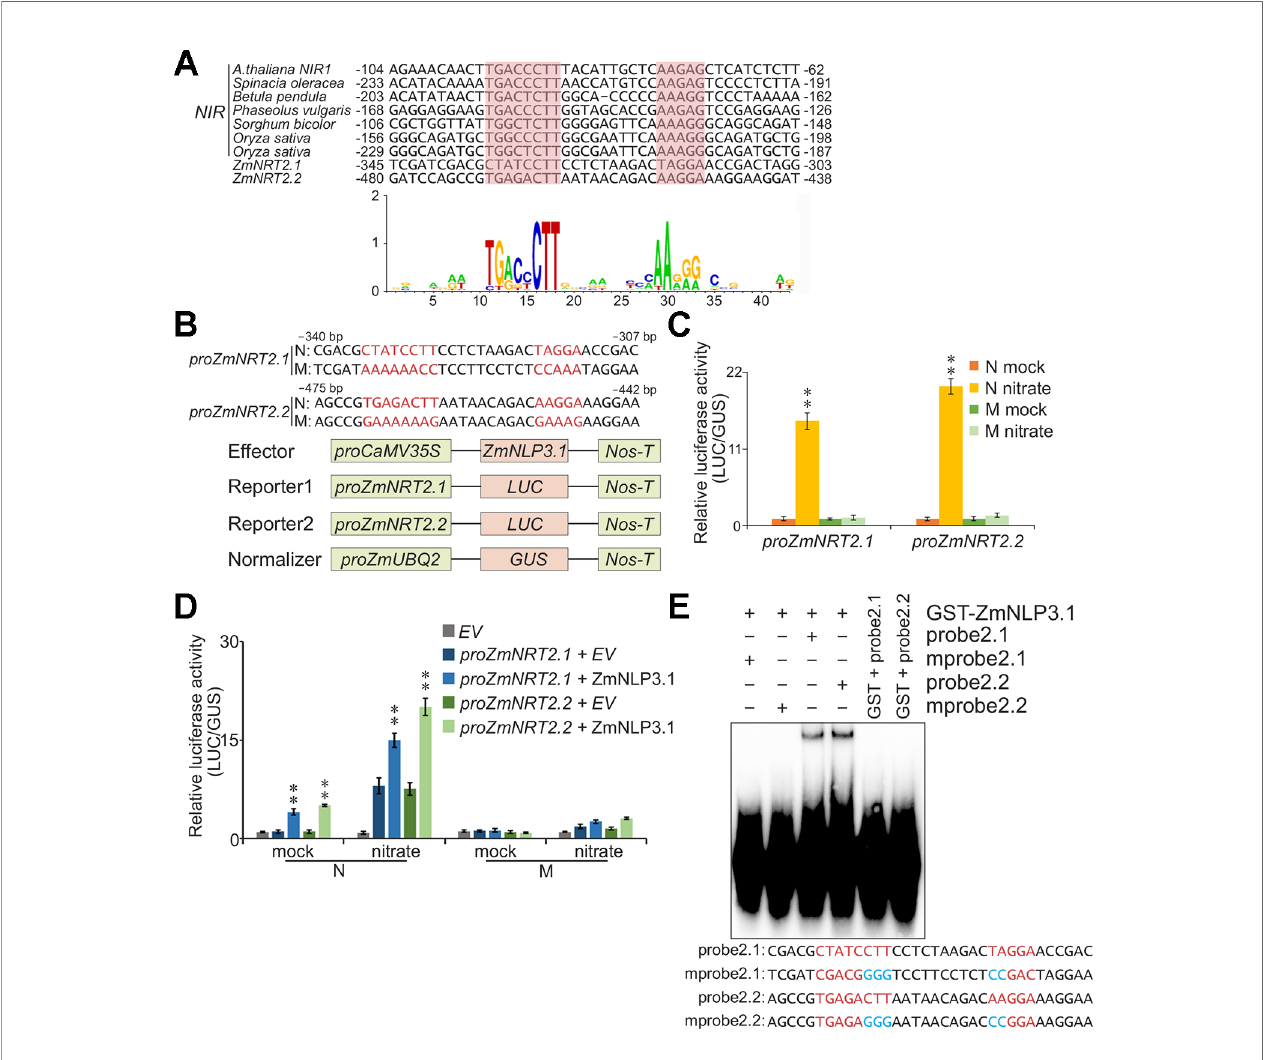
FIGURE 5 | ZmNLP3.1 binds to the promoter regions of ZmNRT2.1 and ZmNRT2.2 via the recognition of NREs and activates gene transcription. (A) Nucleotides sequences of nitrate-responsive cis -elements (NREs) found in the fl anking regions of ZmNRT2.1 and ZmNRT2.2 . The NREs of NIR genes of Arabidopsis thaliana , Spinacia oleracea , Betula pendula , Phaseolus vulgaris , Sorghum bicolor , and Oryza sativa are indicated. The consensus sequence of NRE is displayed using the sequence logo generation program WebLogo (Crooks et al., 2004). The p -values for the prediction of NREs in ZmNRT2.1 and ZmNRT2.2 gene promoters were 2.78e-6 and 1.29e-7, respectively. (B – D) Transcriptional activation of ZmNRT2.1 and ZmNRT2.2 by ZmNLP3.1 via recognition of the consensus sequence. (B) Schematic representation of the intact and mutant NREs in ZmNRT2.1 and ZmNRT2.2 promoters. N: normal ZmNRT2.1 or ZmNRT2.2 promoter sequence harboring the motif CTATCCTTN 10 TAGAA or TGAGACTTN 10 AAGGA, respectively. M: variants of the ZmNRT2.1 or ZmNRT2.2 promoter harboring mutant NREs (AAAAAACCN 10 CCAAA or GAAAAAAGN 10 GAAAG, respectively). (C) Nitrate-induced expression of ZmNRT2.1 and ZmNRT2.2 genes in protoplasts, depending on the NRE sequences. Nitrate-free protoplasts were transformed with proZmNRT2.1 or proZmNRT2.2 and normalizer, incubated for 12 h, and then treated with 0.5 mM nitrate for 0 or 2 h. Mock, nitrate treatment for 0 h; nitrate, nitrate treatment for 2 h. N and M indicate the normal and mutant promoter sequences of ZmNRT2.1 or ZmNRT2.2 , respectively, as shown in (B) . The ratio of LUC activity to b -glucuronidase (GUS) activity was calculated. Data represent mean ± SD ( n = 3). Asterisks indicate signi fi cant differences between mock and nitrate conditions (**, p < 0.01; Student's t -test). (D) Transcriptional activation of ZmNRT2.1 or ZmNRT2.2 by ZmNLP3.1 relies on NRE sequences. The proCaMV35S:ZmNLP3.1 vector was cotransformed with a reporter construct containing either ZmNRT2.1 or ZmNRT2.2 promoter and normalizing plasmids in nitrate-free protoplasts. After 12 h incubation, followed by treatment with 0.5 mM nitrate for 0 or 2 h, the LUC and GUS activity was determined. Data represent mean ± SD ( n = 3). Mock, nitrate treatment for 0 h; nitrate, nitrate treatment for 2 h. Asterisks indicate signi fi cant differences between EV and ZmNLP3.1 (**, p < 0.01; Student's t -test). (E) Electrophoretic mobility shift assay (EMSA) for analyzing the binding of ZmNLP3.1 to ZmNRT2.1 and ZmNRT2.2 promoters. Probe2.1 and probe2.2 denote gene-speci fi c biotin-labeled probes of ZmNRT2.1 and ZmNRT2.2 promoters, respectively. In mutant probe 2.1 (mProbe2.1), the sequence CTATCCTTN 10 TAGA in the ZmNRT2.1 promoter was changed to CGACGGGGN 10 CCGAC. Similarly, in mprobe2.2, the sequence